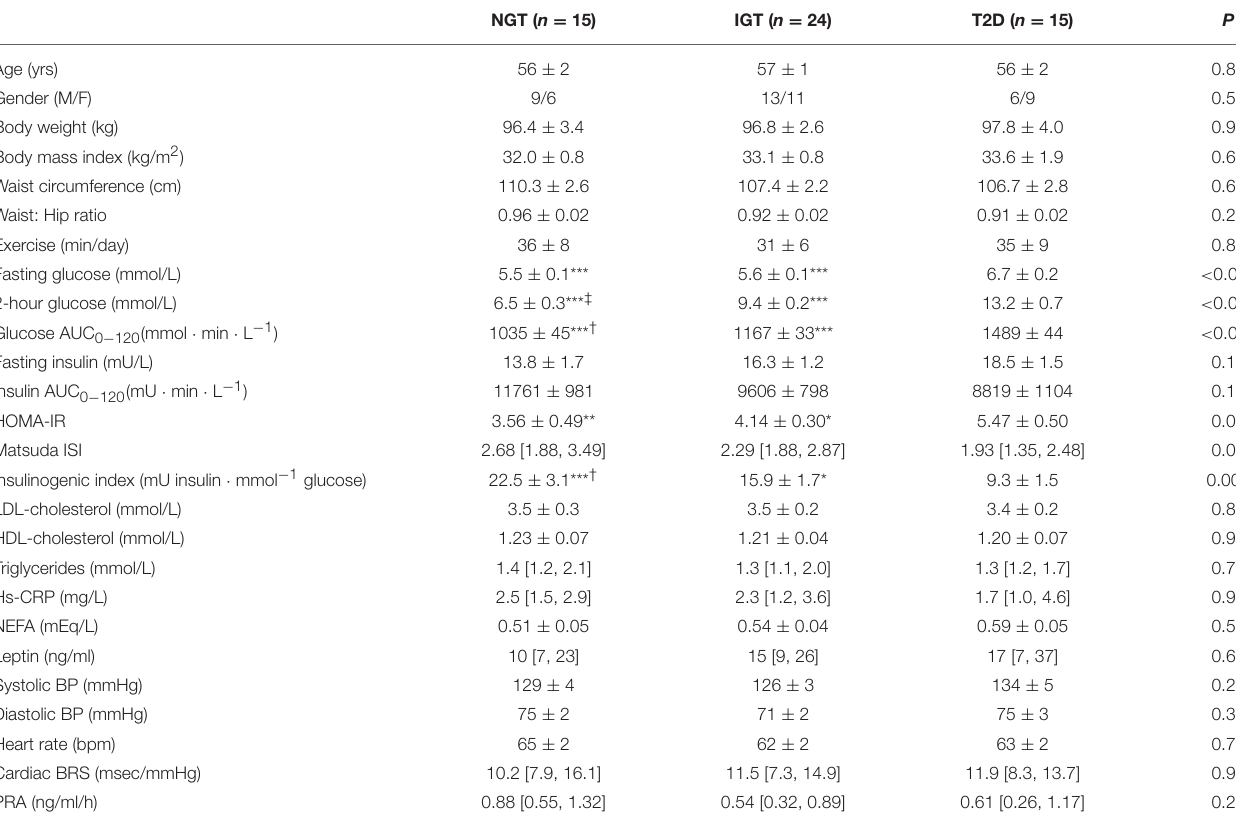
TABLE 1 | Demographic and clinical data at